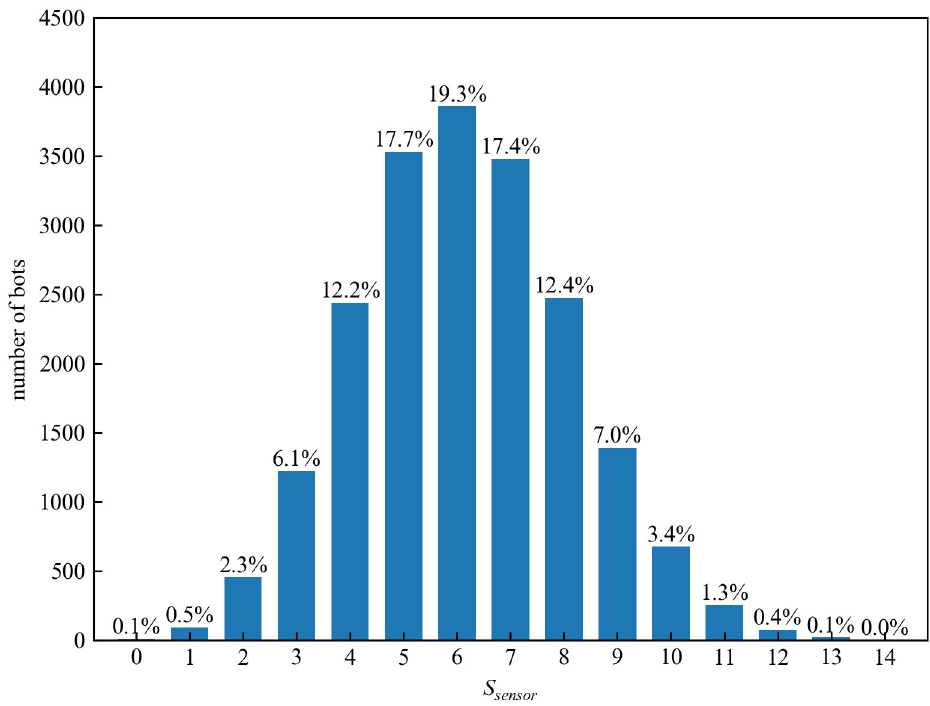
Fig 5. The distribution of the current number of sensor bots in peer lists.